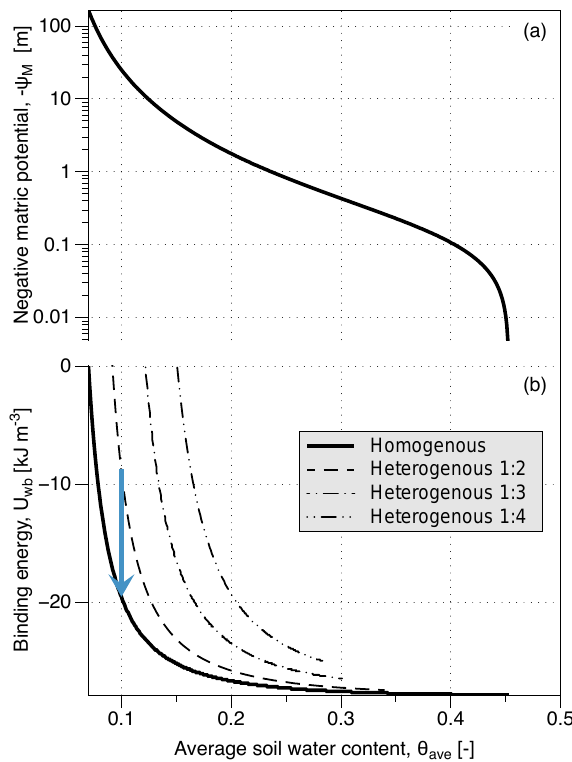
Figure 1. Example of the hydraulic and thermodynamic states of a sample soil (sandy loam; Rawls et al., 1993): (a) water retention curve with logarithmic y axis; parameters are given in Table B1. U wb ,i , as a (b) For the same soil, binding energy, U wb = P n i = 1 function of soil water content, for homogenous and heterogenous soil water distribution in a total soil volume 1m 3 . The ratio indi- cated in the legend corresponds to the ratio of soil water contents in two compartments of equal size but different soil water content. The blue arrow indicates how much energy is available for driving fluxes to equalize the gradients in water potentials between